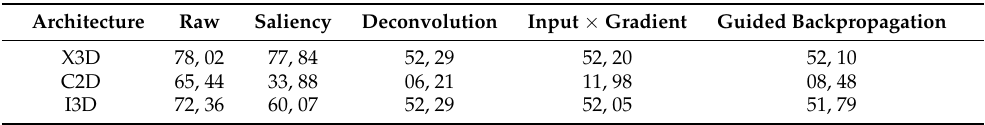
Table 5. Results of the spatial analysis on the test set. As in Table 4, this table presents the f-measure value for each model evaluated in the test set based on the sanity-check analysis. The meaning of each column is the same as in Table 4, except that here is the spatial sanity